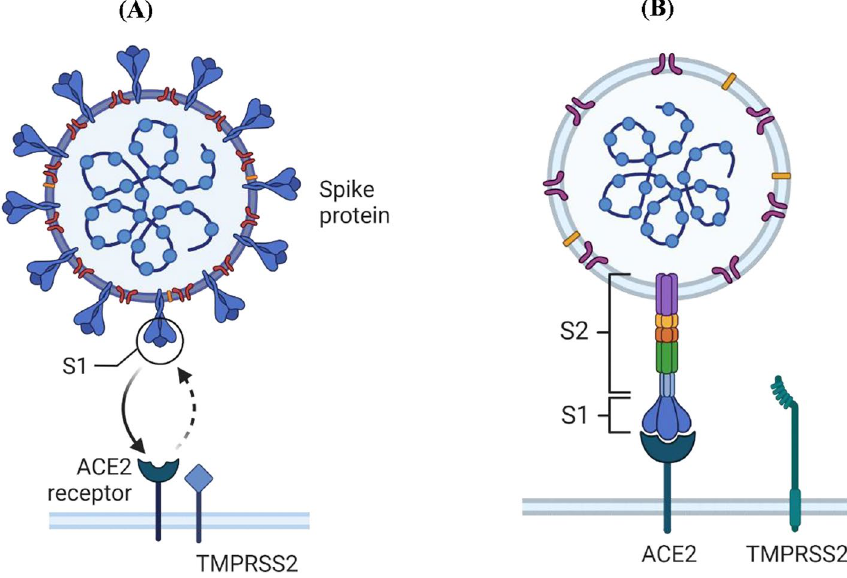
Figure 1. The structure of SARS-CoV-2 and the ACE2 receptor (Created with